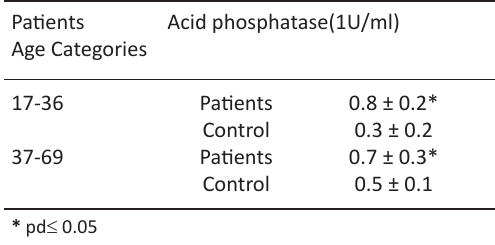
Table 5. Acid phosphatase activity in patients with Brucellosis and healthy